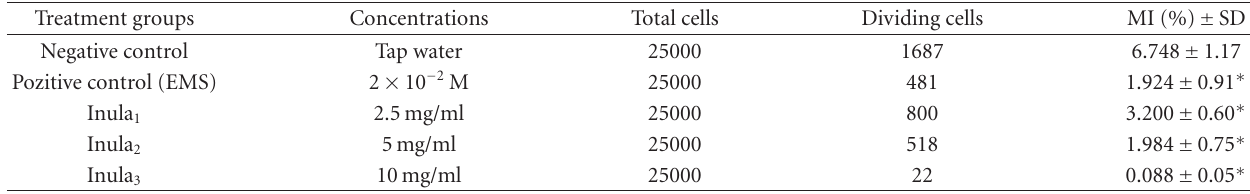
Table 2: The dividing and total cells counted in microscopic observations and mitotic values in control and in treatment concentrations. Treatment groups